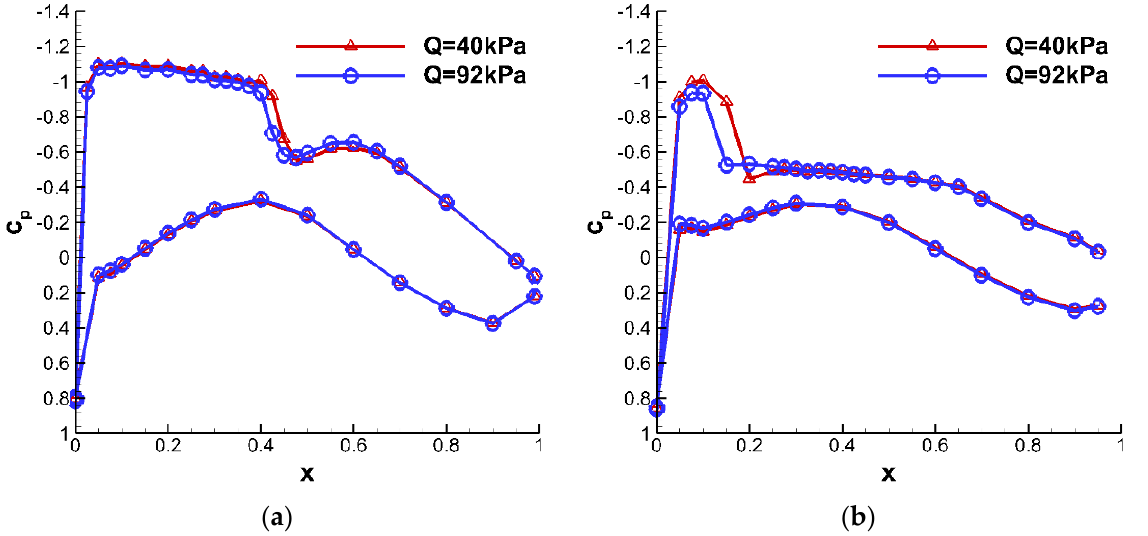
Figure 7. Pressure distributions under different dynamic pressures (α = 2°, M = 0.76, Re = 15 × 10 6 ): ( a ) η = 54%; ( b ) η = 96.61%.